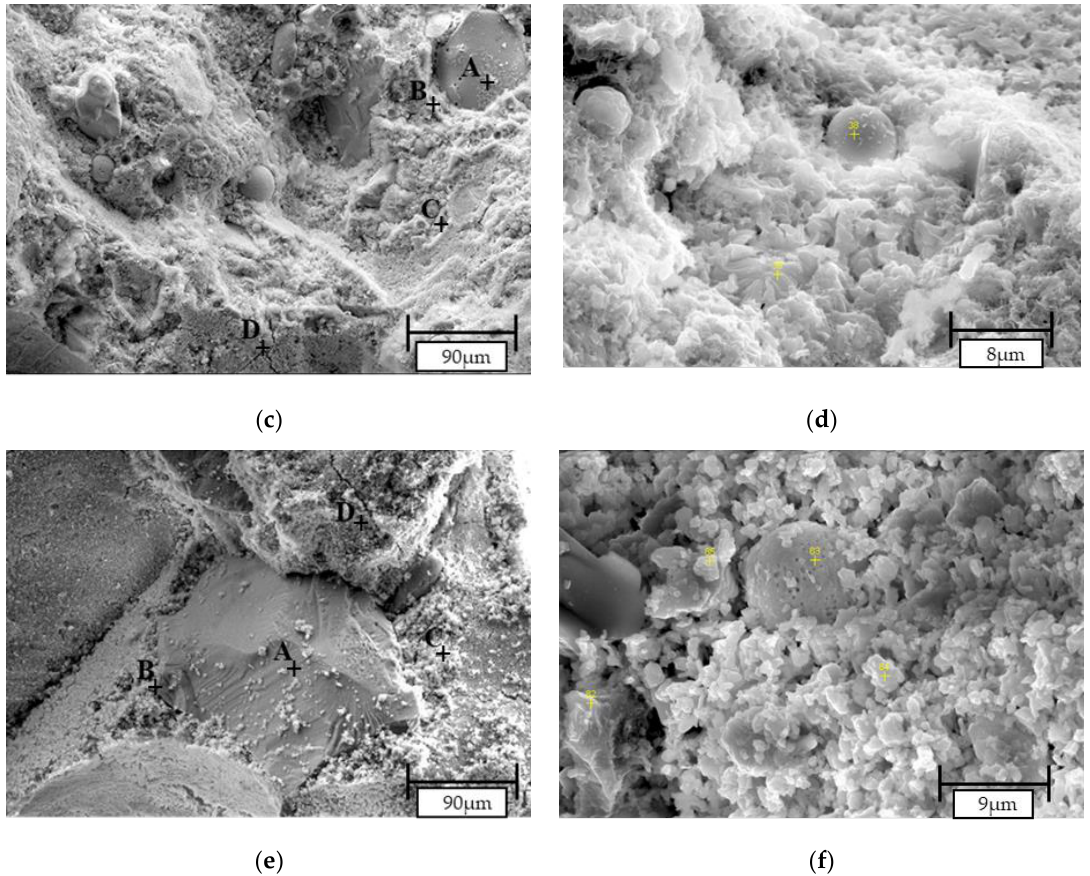
Figure 11. SEM pictures of mortars alkali-activated with N5-C10: ( a , b ) RFA, CFA ( c , d ), and BFA ( e , f ). *A—aggregate, B—interface between gel and aggregate, C—aluminosilicate/geopolymer paste, and D—microcracks.